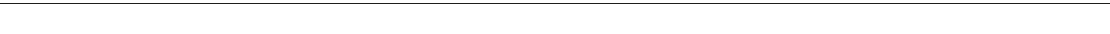
Fig. 6 IRF8 expression is reduced during breast and pancreatic cancer. a IRF8 measured in BM MDPs, CDPs, and pre-DCs of end-stage orthotopic PyMT- B6 tumor-bearing mice and tumor-free controls; n = 7/group. Data are representative of three independent experiments. b RT-qPCR analysis of BM GMPs, MDPs, and CDPs sorted from mice bearing end-stage orthotopic PyMT-B6 mammary tumors and tumor-free controls for IRF8 target genes, four samples consisting of two mice each were analyzed per group. c pSTAT3 measured in BM MDPs, CDPs, and pre-DCs of end-stage orthotopic PyMT-B6 tumor- bearing mice and tumor-free controls; n = 6. Data are representative of two independent experiments. d IRF8 expression in total BM from BC and PDAC patients relative to healthy controls; n = 10/group. Data are from BC cohort 1 and PDAC cohort 1. e Correlation between BM pre-DCs and BM IRF8 expression in BC and PDAC patients. Data are from BC cohort 1 and PDAC cohort 1; n = 20. f IRF8 expression in blood pre-DCs from PDAC patients relative to healthy controls; healthy controls n = 10, PDAC n = 43. Data are from PDAC cohort 2. g Correlation between blood pre-DCs and blood pre-DC IRF8 expression in PDAC patients; n = 43. Data are from PDAC cohort 2. h Kaplan – Meier estimate of recurrence free survival and overall survival of patients + / − median blood pre-DCs IRF8 expression. Log-rank (Mantel – Cox) p value is denoted for differences in recurrence-free survival and overall survival. Data are from PDAC cohort 2. Spearman ’ s correlation ( r 2 , correlation coef fi cient). End stage for each model is de fi ned in the Methods. Error bars represent mean + / − s.e.m or box plot; * p < 0.05, ** p < 0.01, *** p < 0.001 by unpaired two-sided Student ’ s t